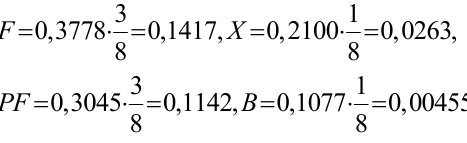
Grupe elemenata sa koeficijentima nakon korekcije dobijenih vrednosti koeficijenata zna č ajnosti Grupa